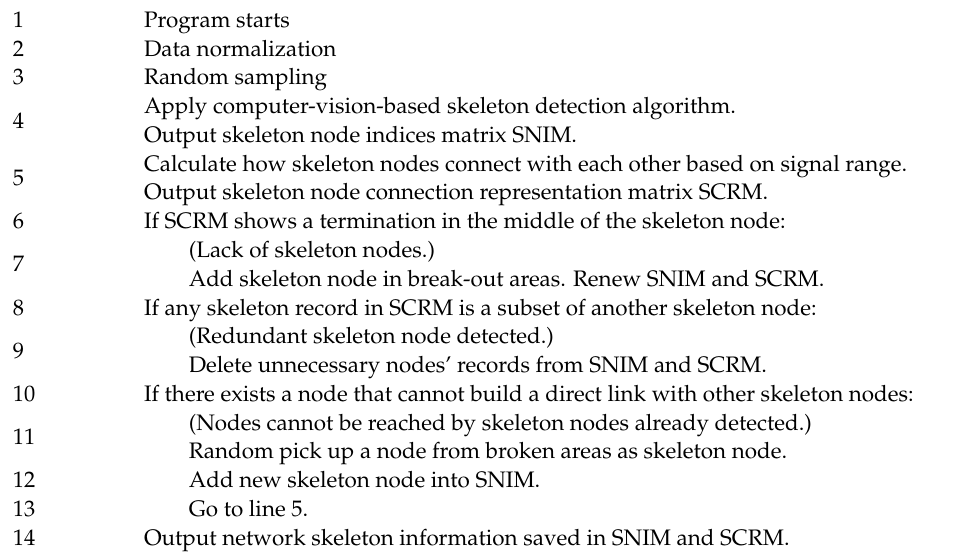
Algorithm 1. Network skeleton detection algorithm